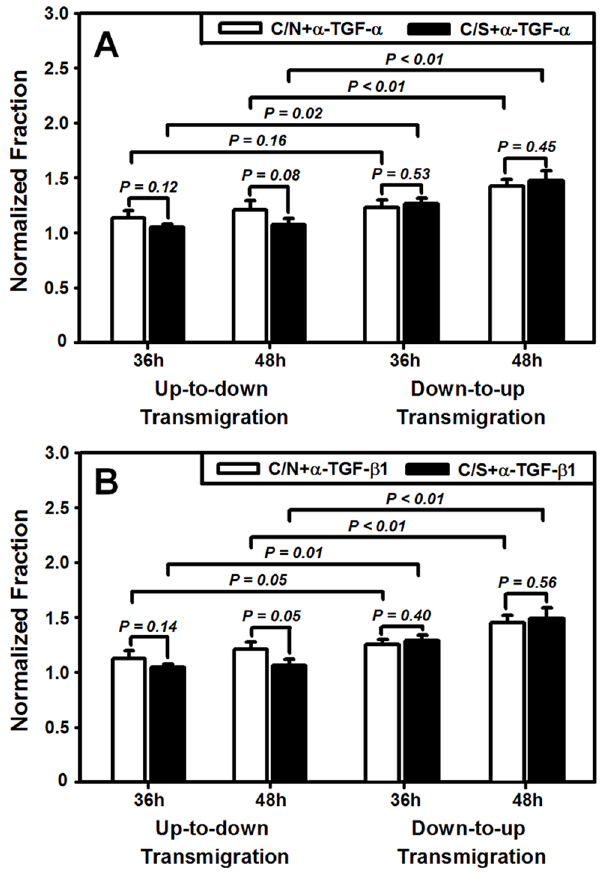
Figure 9. Inhibition of TGF- a ( A ) or TGF- b 1 ( B ) in transmigration of HaCaT cells. Data were presented as the mean 6 SD of fraction of transmigrated HaCaT cells at t =36, 48 h normalized to that at t =24 h in respective cases. Data at t =24 h were not presented for the sake of clarity.